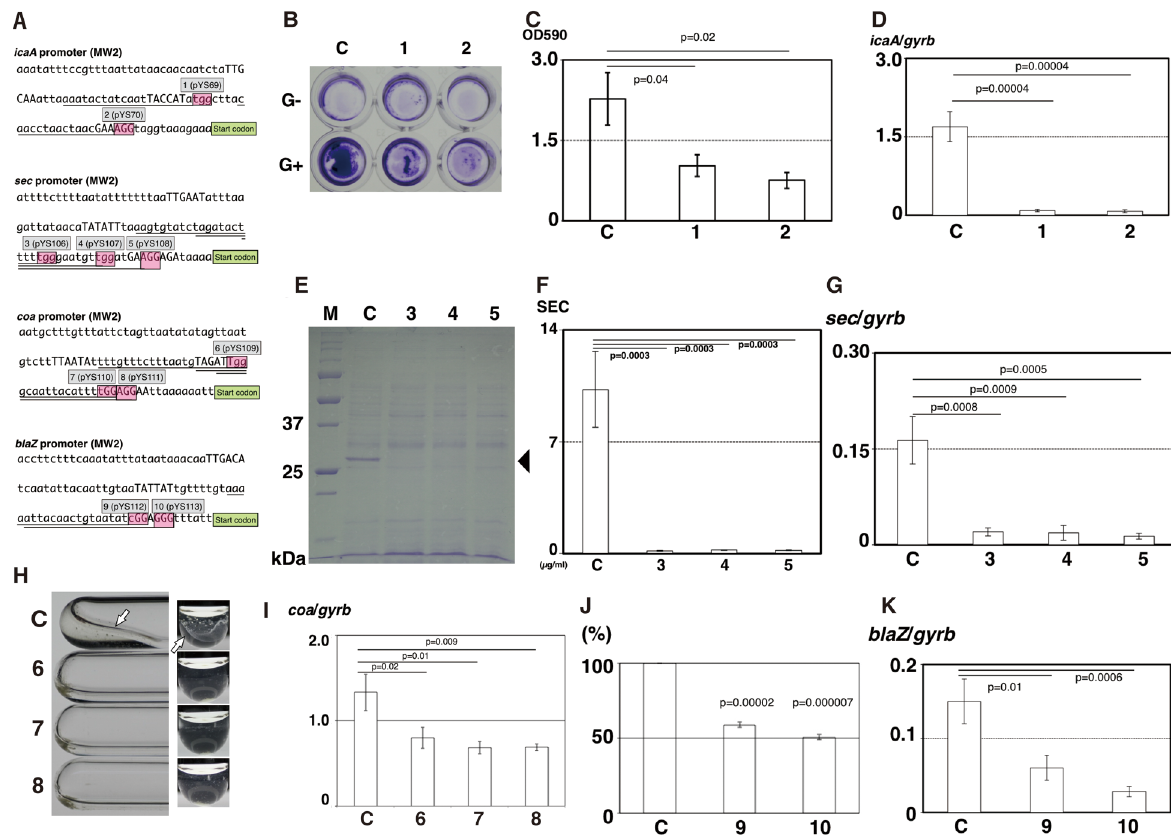
Fig 4. Repression of various virulence and antibiotic resistant factors in MW2 using CRISPRi. Knockdown strain names were as follows. C: MW2/pBACi (Vector control), 1. MW2/pYS69 ( icaA silenced knockdown strain 1), 2: MW2/pYS70 ( icaA silenced knockdown strain 2), 3: MW2/ pYS106 ( sec silenced knockdown strain 1), 4: MW2/pYS107 ( sec silenced knockdown strain 2), 5: MW2/pYS108 ( sec silenced knockdown strain 3), 6: MW2/pYS109 ( coa silenced knockdown strain 1) 7: MW2/pYS110 ( coa silenced knockdown strain 2), 8: MW2/pYS111 ( coa silenced knockdown strain 3), 9: MW2/pYS112 ( blaZ silenced knockdown strain 1), and 10: MW2/pYS113 ( blaZ silenced knockdown strain 2). All phenotype assays were repeated at least three times (qPCR and ELISA: three independent cultures and three independent measurements. Other assays: three independent assays). Average and SE of each assay are shown in graphs. Statistics: Student’s t -test. 4A. crRNA binding regions. 100bp upstream sequences of four genes in MW2 and nucleotide sequences corresponding to spacer sequences designed in this study. Underline: spacer sequences, red boxes: PAM sequence (NGG), start codon: start codon of gene, capital letters: putative -35b, -10b and ribosome binding sites of genes. 4B. Biofilm formation on plastic surfaces. After 24 h culture, the amount of biofilm on surface was assayed. G-: without additional glucose, G+: with additional glucose. 4C. OD 590 value of extracts from G+ wells as shown in Fig 4B. 4D. Repression of icaA mRNA. 4E. SDS-PAGE of supernatants. Culture media were subjected to electrophoresis. Arrow head: Protein corresponding to SEC (SEC from MW2: 28kDa). M: molecular weight marker (kDa), 4F: Sandwich ELISA of supernatants. SEC production was quantified. 4G. Repression of sec mRNA. 4H. Coagulase test. White arrow indicates a fibrin clot. 4I. Repression of coa mRNA. 4J. Measurement of β -lactamase activity. OD 490 of nitrocephin degraded product was measured. The value of control was compared with silencing vectors (%, vertical line). 4K. Repression of blaZ